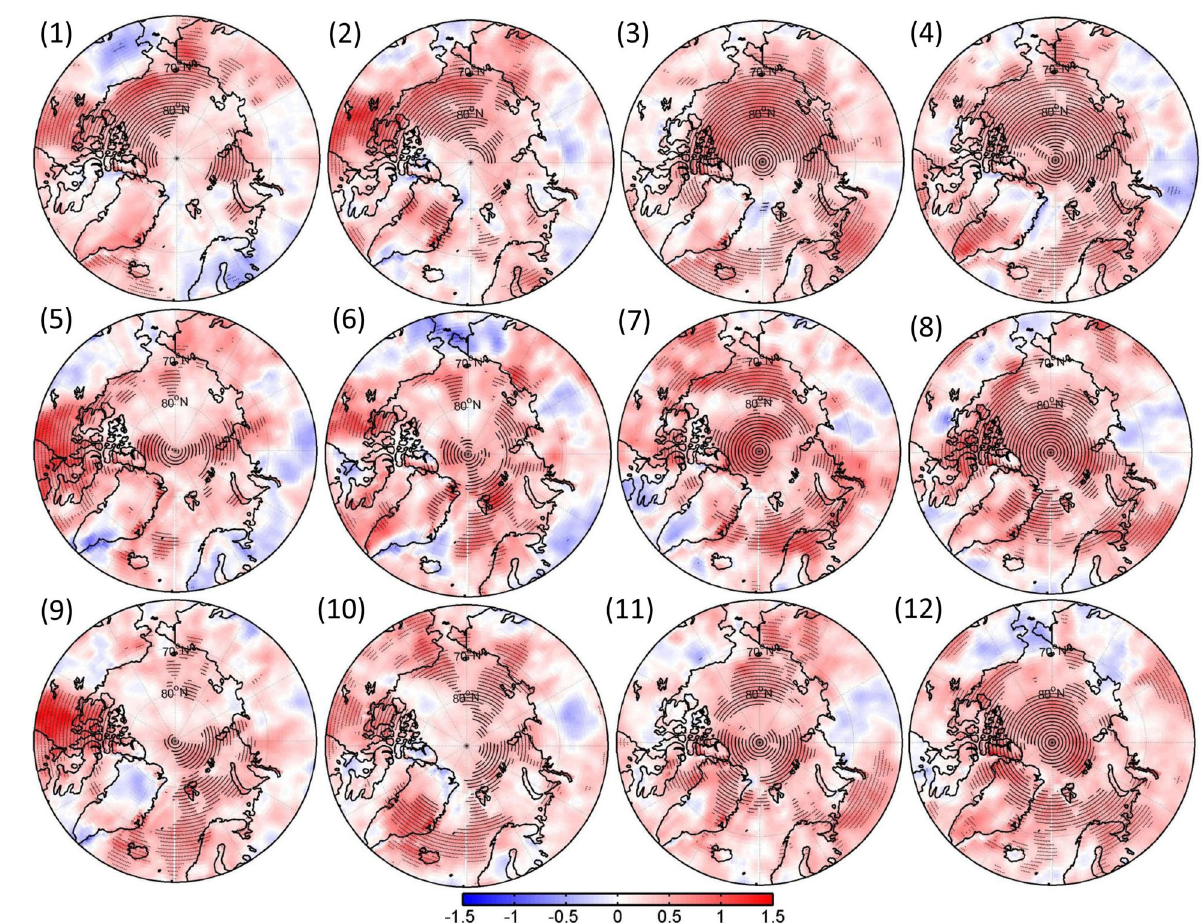
Fig. 11 Trends in surface downward longwave radiation for each node (unit: W m − 2 s yr − 1